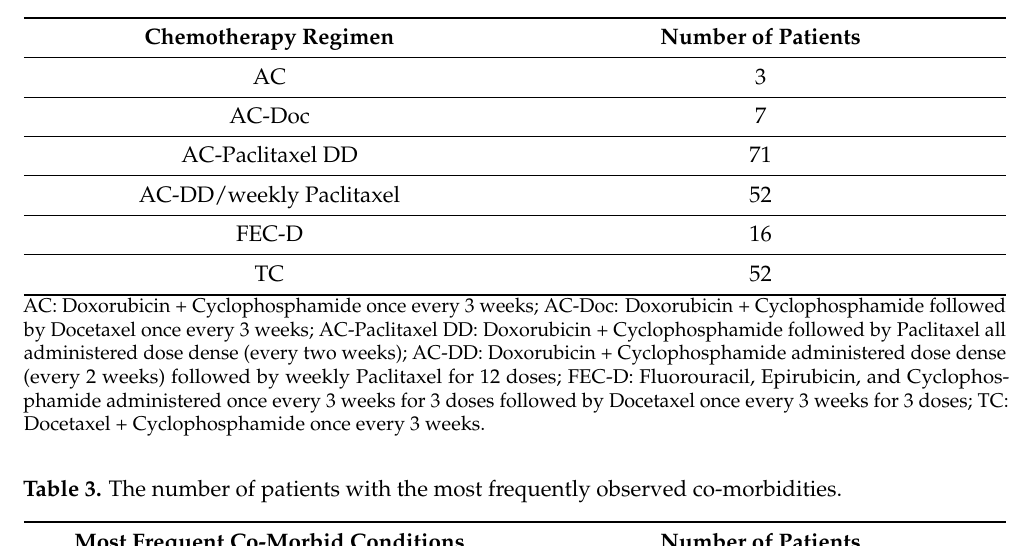
Table 2. The number of patients who received each chemotherapy.